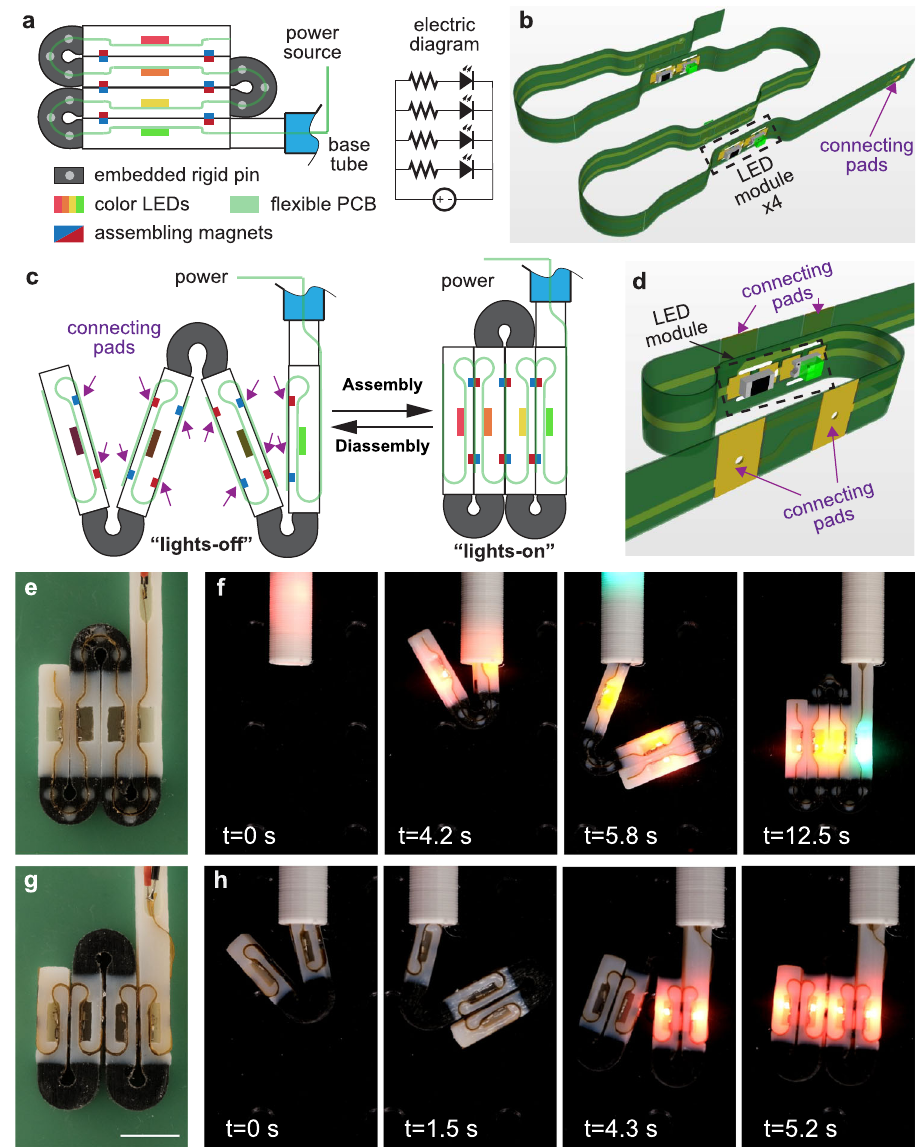
Fig. 6 | Integration of fl exible PCBs and LEDs into the functional